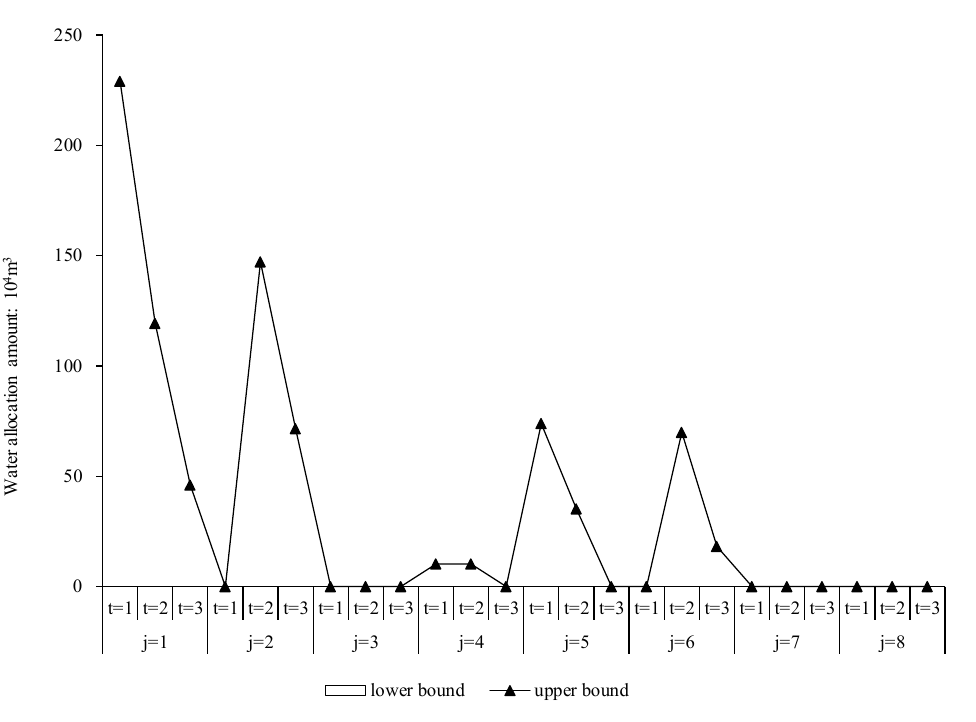
Figure 3. Reused water resource allocations for industry.